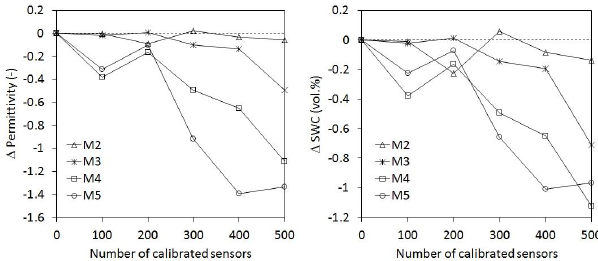
Figure 6. Alteration of reference liquids (M3–M5) during the calibration of 500 SMT100 sensors (left and right panel present permittivity and equivalent SWC calculated with the Topp equation [36], respectively). The values represent the deviations from the permittivity of the fresh reference media. The deviations were derived from the average response of two SMT100 sensors that were repeatedly used to measure the permittivity during the calibration of 500 SMT100 sensors (i.e., always after 100 calibrations). The results for M2 (glass beads) are also presented for